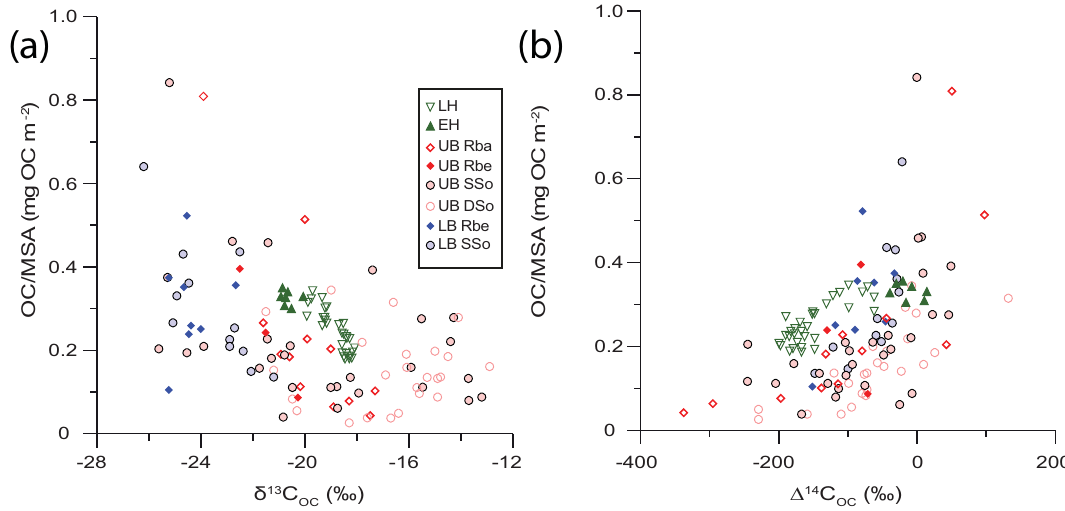
Figure 5. Organic carbon loading vs. (a) δ 13 C OC and (b) (cid:49) 14 C OC , for Godavari river basin and marine sediment core 16A. The (cid:49) 14 C values for marine sediments refer to the age-corrected value ( (cid:49) ). Symbol key and abbreviations are as for Figs. 1 to